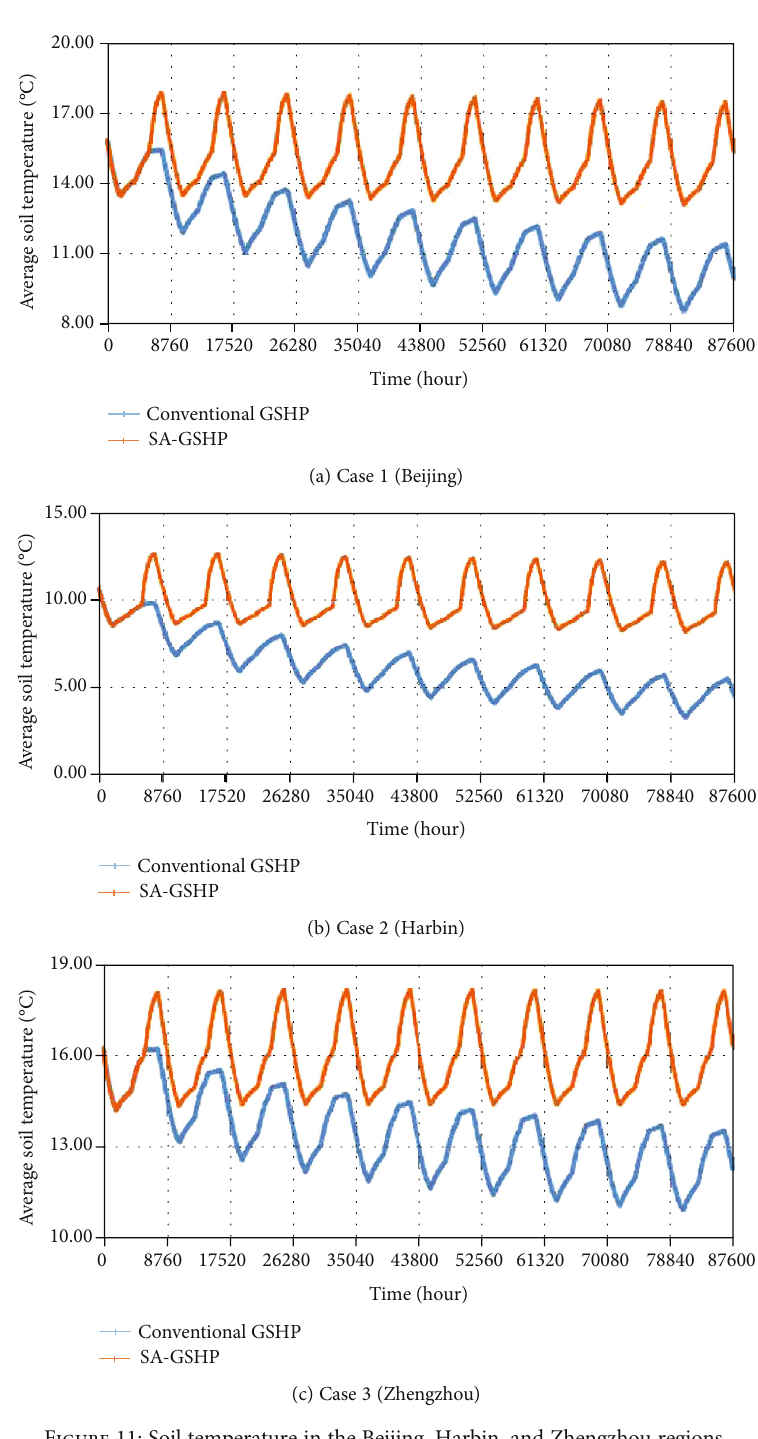
Figure 11: Soil temperature in the Beijing, Harbin, and Zhengzhou